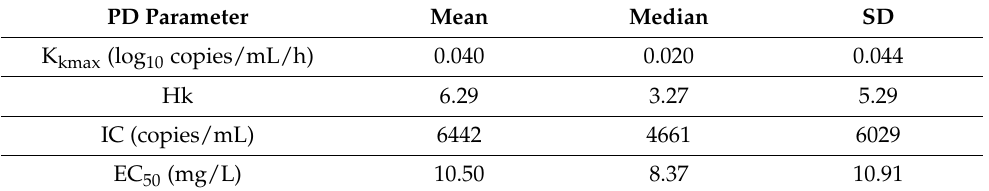
Table 3. PD parameters of final PK/PD model ( N = 4).